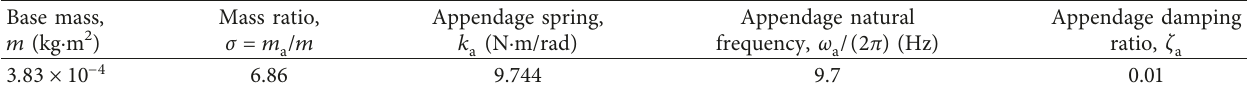
Figure 6: Generic optimal design curve (thick line) in the specific design region (shaded area) for a given manipulator of the mass ratio σ 6 . 86. The system bandwidth and damping requirements are represented by ω s / ω a and η e , respectively. (cid:31) Table 1: Identified lumped elements of the mechanical manipulator.